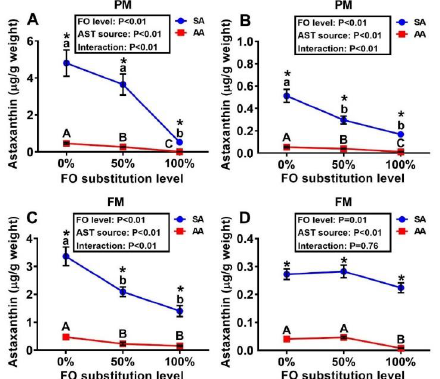
Figure 1. Effects of dietary fish oil (FO) substitution by docosahexaenoic acid (DHA)-rich microalgae and source of astaxanthin (AST) on astaxanthin concentrations in the muscle (fillet, A , C ) and liver ( B , D ) of juvenile rainbow trout fed the plant meal- (PM, A , B ) and fishmeal (FM, C , D )-based diets. Means labelled with different letters [lowercase (a, b), synthetic astaxanthin (SA) groups; uppercase (A–C), microalgae astaxanthin (AA) groups] are different between various fish oil substitutions ( p < 0.05). Asterisks (*) indicate differences between SA and AA groups ( p < 0.05) at the same level of FO substitution. FO: fish oil. AST: